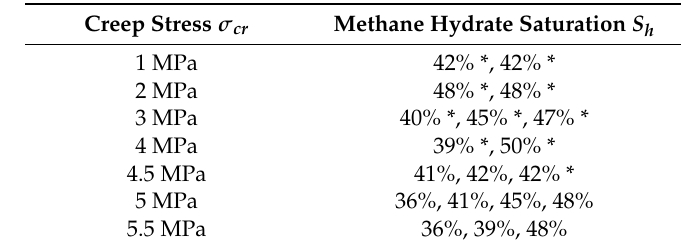
Table 3. Conditions of creep